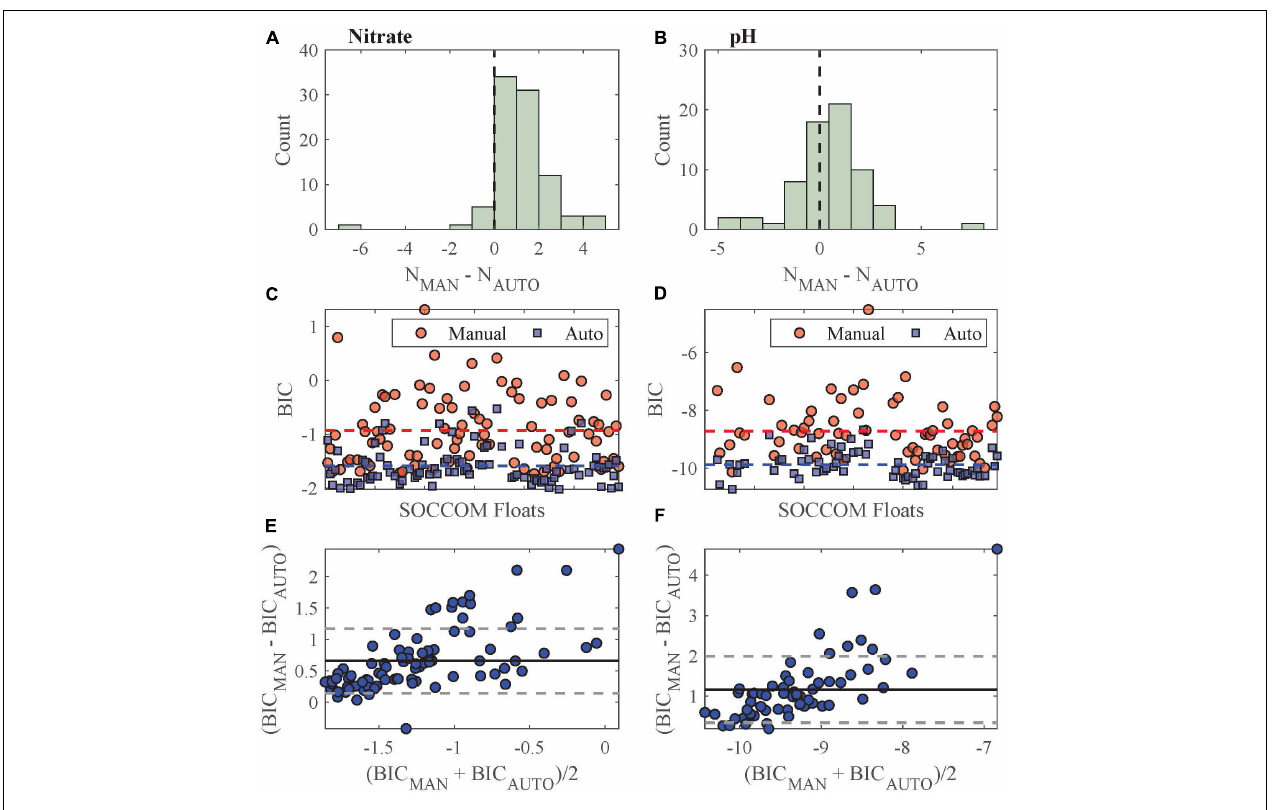
FIGURE 9 | (A,B) Histograms showing differences in number of changepoints identified by the manual (N MAN ) versus automated (N AUTO ) method for nitrate and pH sensor QC. (C,D) Comparison of computed Bayesian Information Criterion (BIC) for manual (red circles) and automated (blue squares) changepoint identification in nitrate and pH QC. Dashed lines represent mean BIC values for each method. (E,F) Difference in computed BIC (manual versus auto) against mean BIC value for each float, for nitrate and pH. Solid and dashed lines represent mean difference ± 1 SD, respectively. A total of 120 SOCCOM floats were used in each